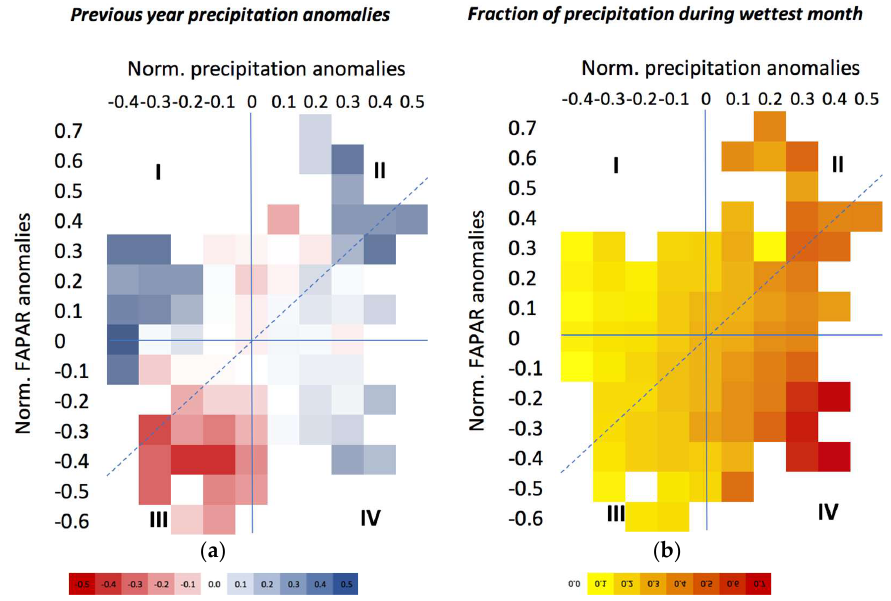
Figure 6. Average previous year precipitation anomalies ( a ) and fraction of the total yearly precipitation during wettest month of the year ( b ) for each normalized FAPAR and precipitation anomalies, as provided in Figure 5. In ( a ), red represents the negative precipitation anomalies and blue the positive precipitation anomalies. The lighter the colors, the smaller the anomalies. In ( b ), yellow represents low precipitation anomalies, and red, large precipitation anomalies during the wettest month of each year.